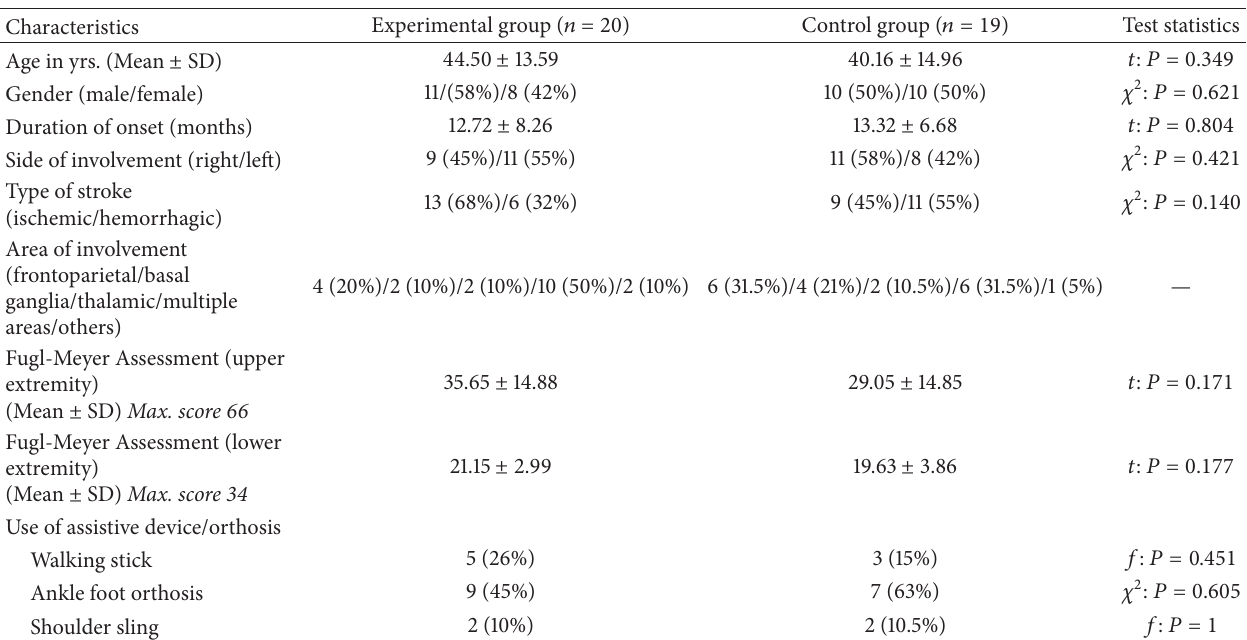
Table 1: Demographic characteristics and motor status of the participants.